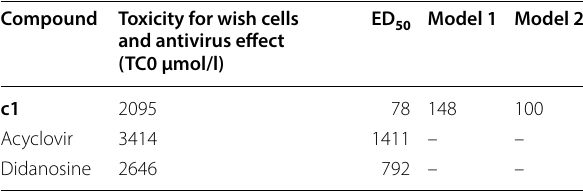
Table 29 Experimental antiviral results of compound c1 Compound Toxicity for wish cells and antivirus